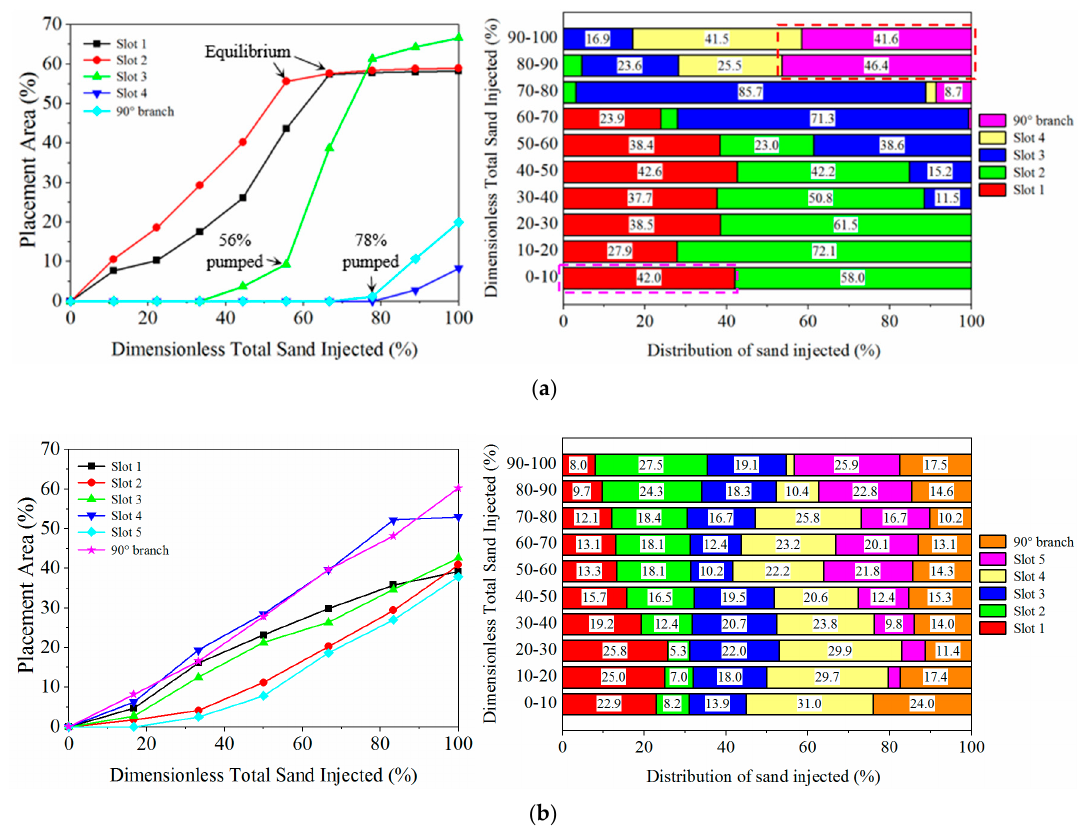
Figure 4. Evolvement of the dunes under different pumping rates, ( a ) case 1 under a pumping rate of 5.40 m 3 /h, ( b ) case 4 under a pumping rate of 12.60 m 3 /h. 5.40 m 3 / h, ( b ) case 4 under a pumping rate of 12.60 m 3 /